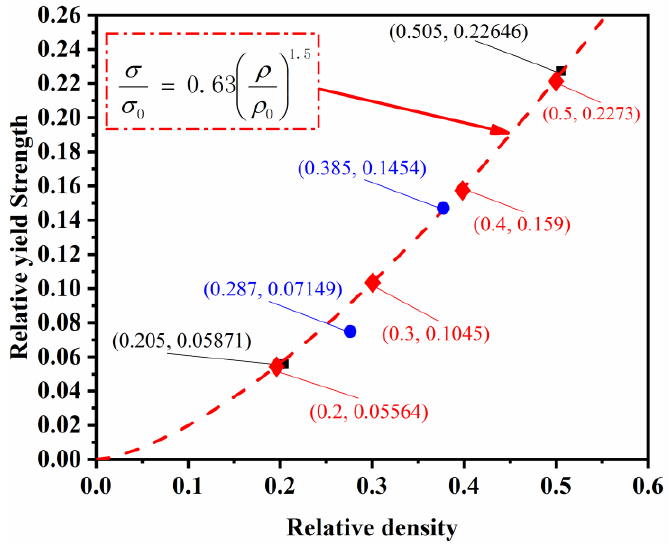
Figure 13. Relative elastic modulus-relative density fitted curves of ULSs.